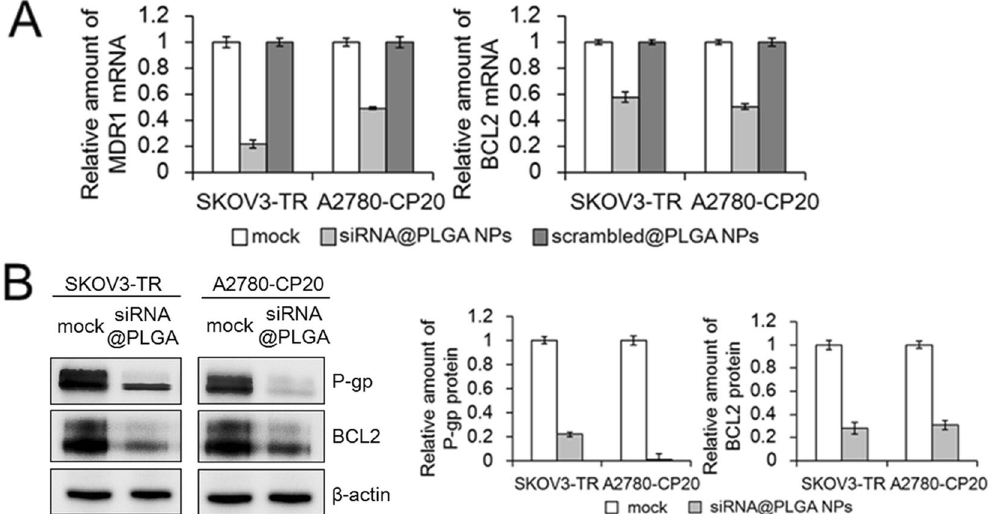
Figure 4. Quantitative measurement of gene silencing for MDR1 and BCL2 on MDR ovarian cancer cells treated with siRNA@PLGA NPs. ( A ) The mRNA levels of MDR1 and BCL2 were determined by qRT-PCR method 24 h after SKOV3-TR and A2780-CP20 cells were treated with PLGA NPs containing MDR1 and BCL2 siRNA. ( B ) The expression levels of P-glycoproteins and BCL2 proteins were measured by immunoblotting method 24 h after SKOV3-TR and A2780-CP20 cells were treated with siRNA@PLGA NPs. In the figure are reported the cropped gels/blots obtained by each protein evaluation. All gels were run in the same experimental conditions and a representative immunoblotting image was presented. The levels of P-glycoproteins or BCL2 proteins were quantitatively plotted relative to those of mock sample cells. All results are represented as the mean ± s.d. (n =